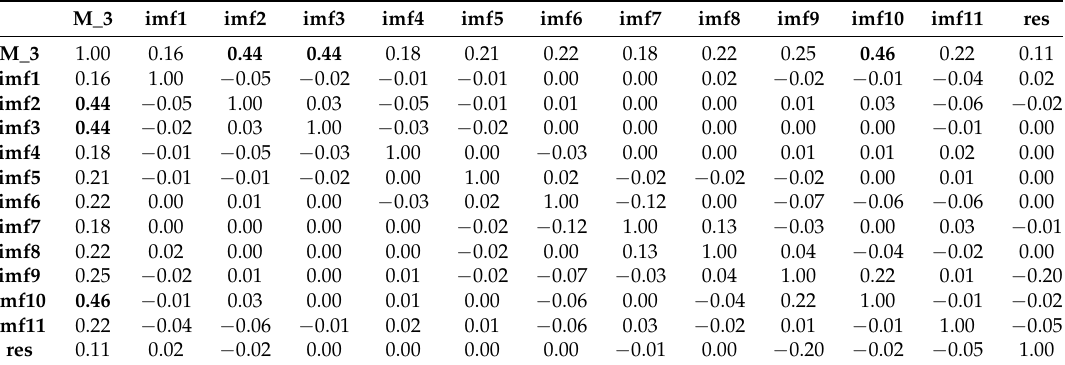
Table A3. M_3 load component correlation coefficient table.